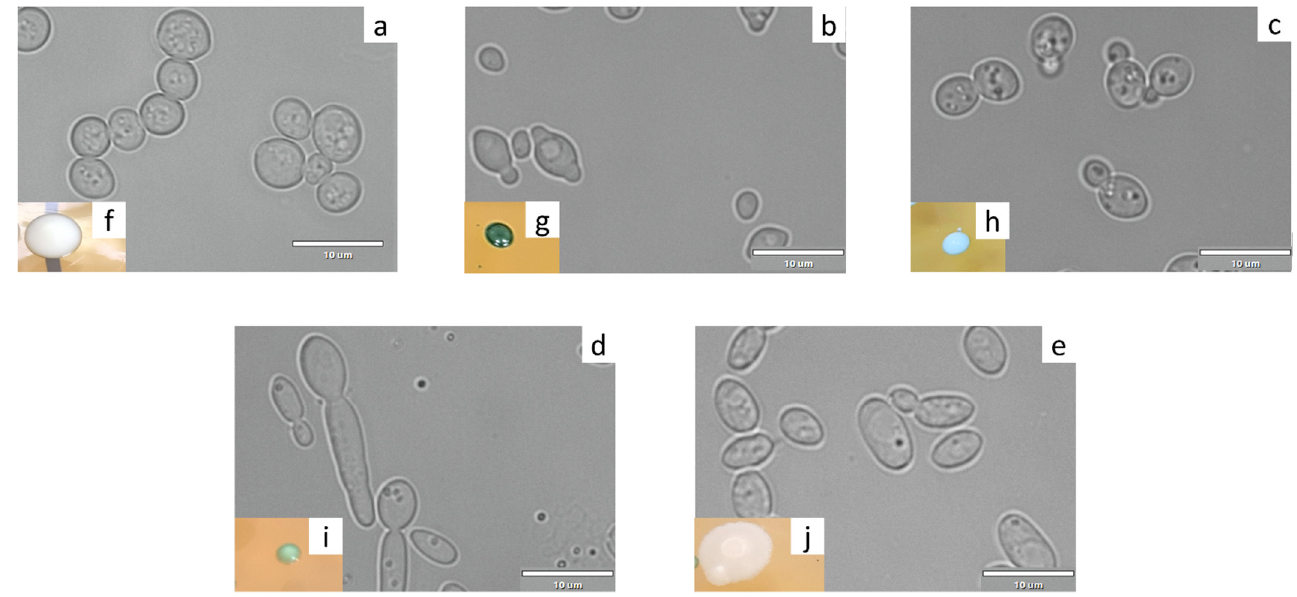
Figure 2. Cell and colony morphologies on WL agar medium of yeast identified in green and black tea kombuchas: ( a , f ) Saccharomyces cerevisiae , ( b , g ) Hanseniaspora. valbyensis , ( c , h ) Zygosaccharomyces florentinus, ( d , i ) Dekkera/Brettanomyces bruxellensis , ( e , j ) Candida californica .